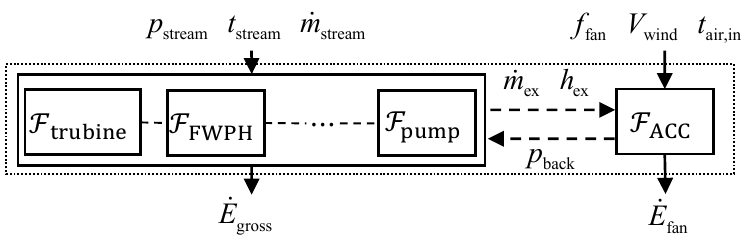
. . E gross and E fan